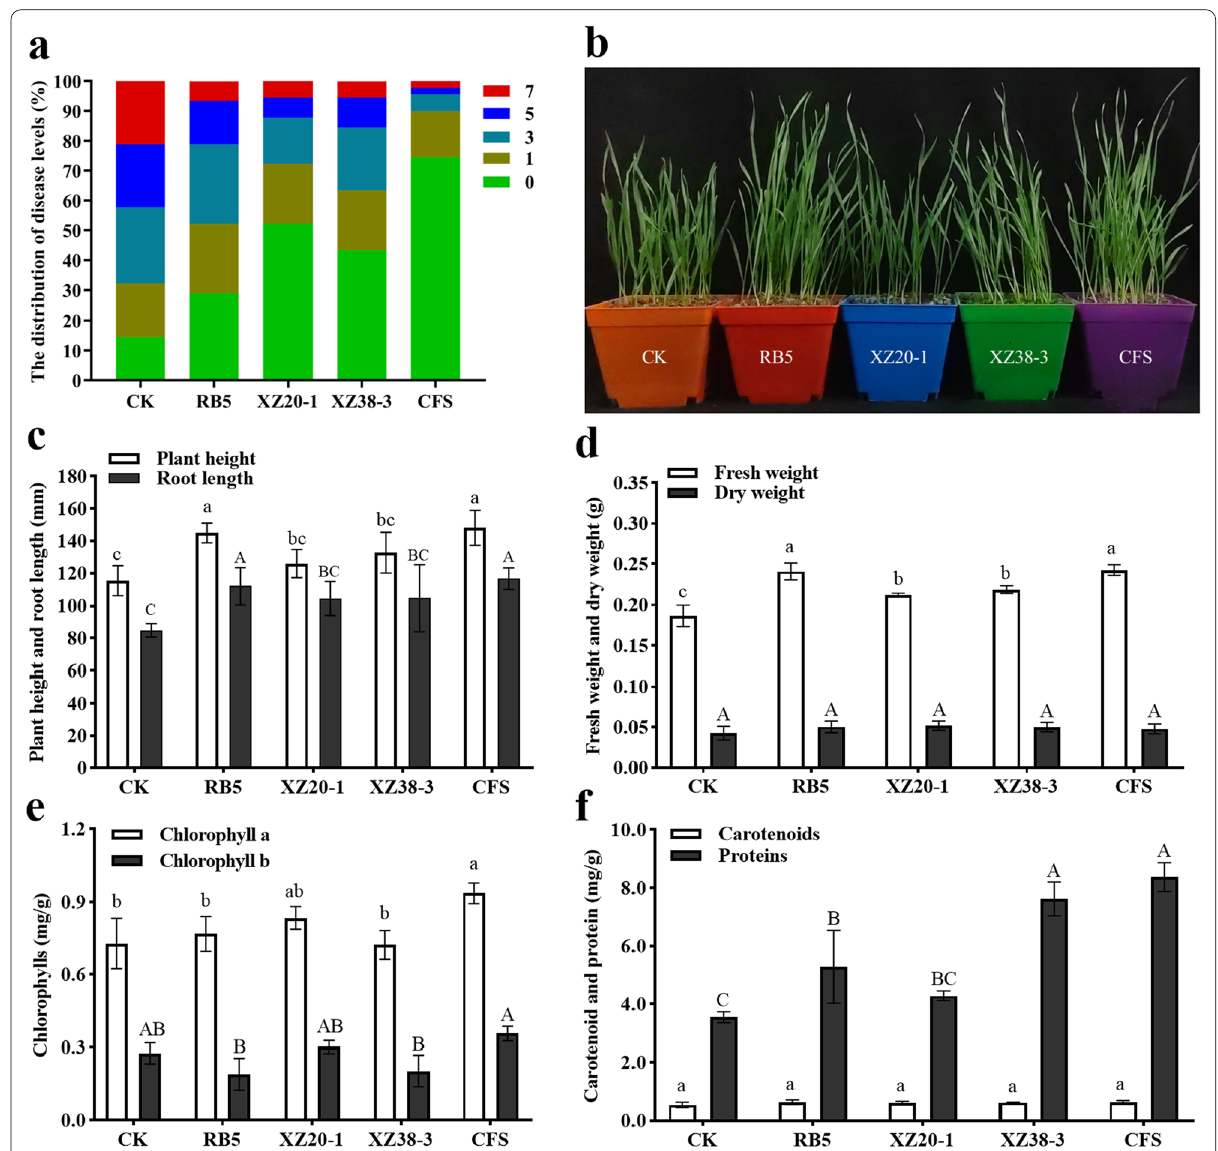
Fig. 6 Effects of fermentation supernatants of strains. a The distribution of disease levels of wheat sheath blight in each group; b Growth difference of wheats; c Plant height and root length of wheats; d Fresh and dry weight of wheats; e Chlorophylls a and chlorophylls b; f Carotenoid and protein; Different letters in the figures indicate significant differences ( P < 0.05)